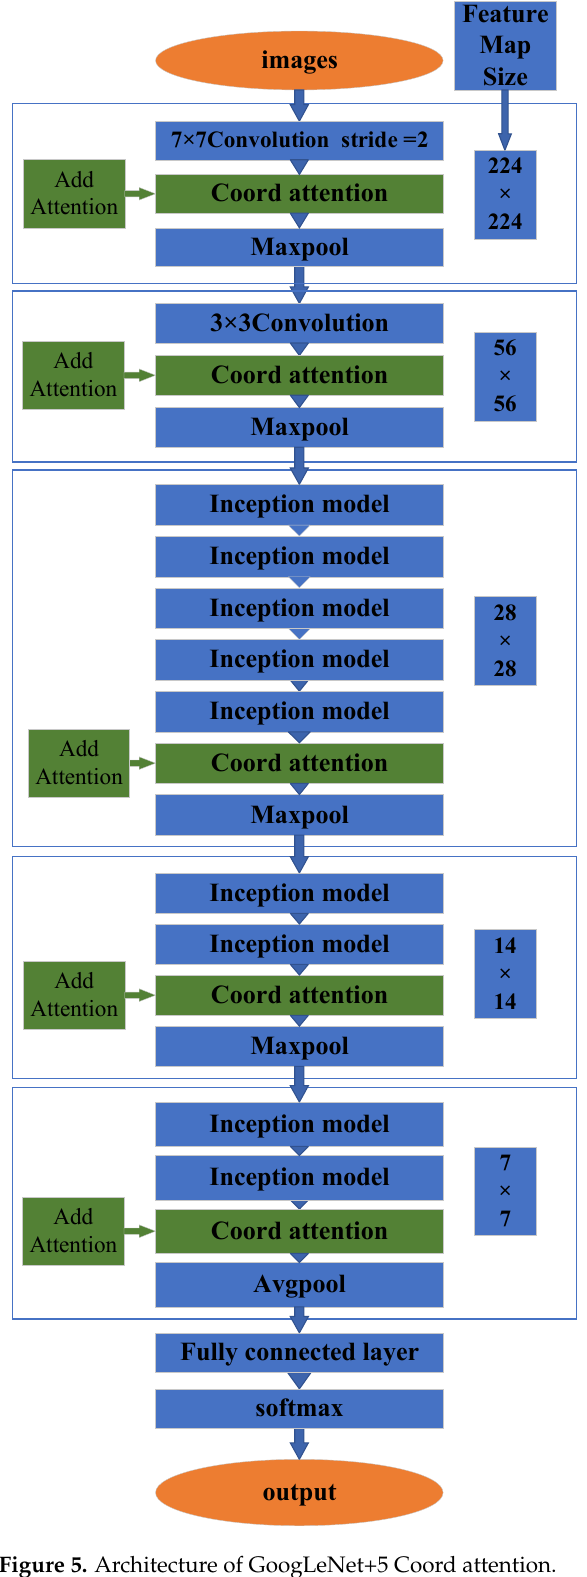
Figure 5. Architecture of GoogLeNet+5 Coord attention.